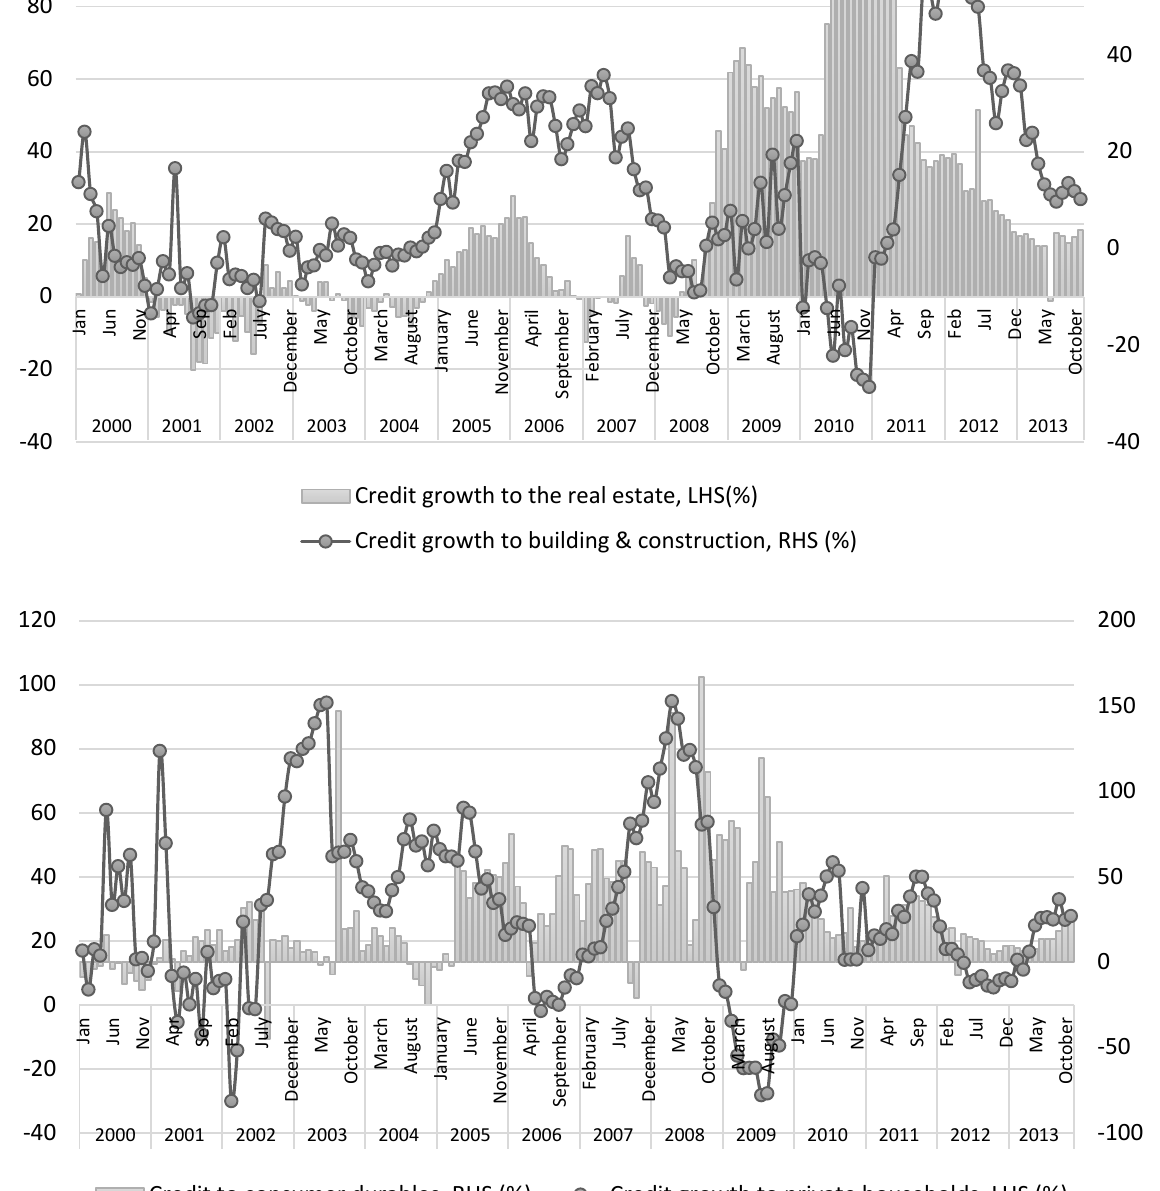
Figure 3b. Private sector credit by sector in the